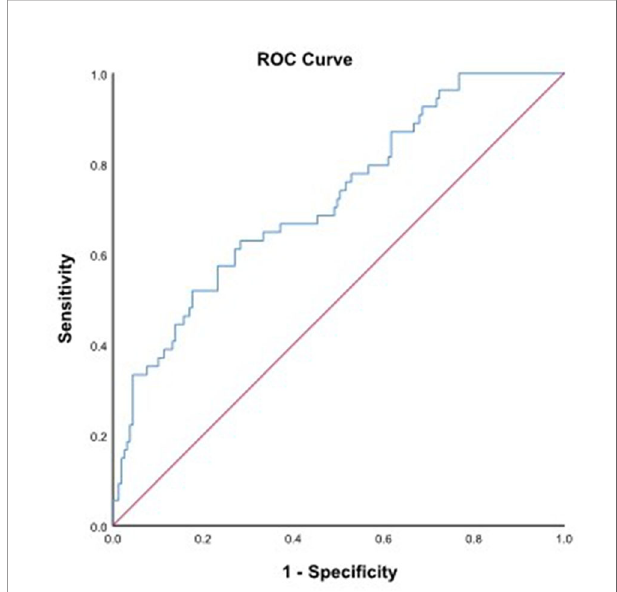
FIGURE 1 | ROC curve for pretreatment SII = 432.48 based on OS ( P =0.011, Sensitivity: 95.0%, Speci fi city: 34.7%, AUC=0.673). ROC, receiver operating characteristic; SII, systemic immune-in fl ammation index; OS, overall